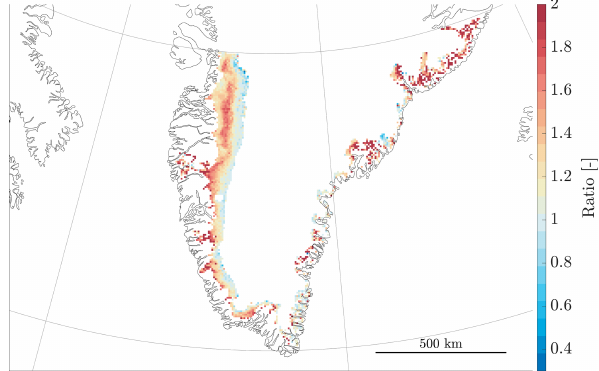
Figure 8. Ratio of parameterized meltwater production with ob- served albedo to parameterized meltwater production with modeled albedo, averaged over the entire study